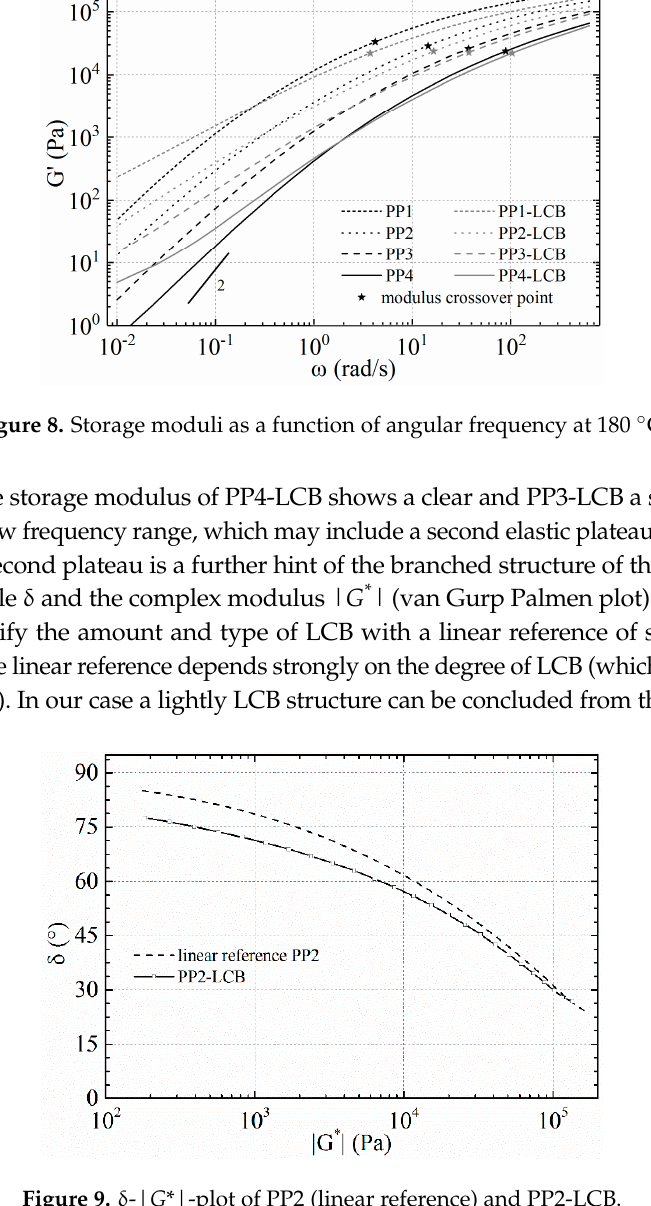
Figure 9. δ -| G *|-plot of PP2 (linear reference) and PP2-LCB.